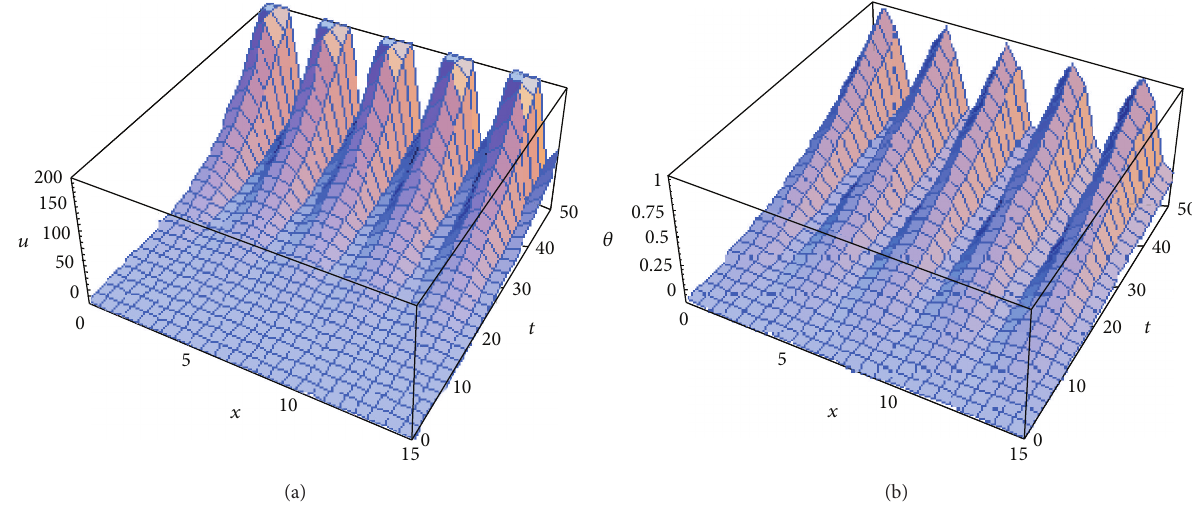
Figure 7: Variations of the displacement 𝑢 and the temperature 𝜃 for various values of the 𝑥 -axis and time 𝑡 when Ω = 𝜎 1 = 𝜎 2 = 0 , 𝜏 2 = 0.2 , = 0.1 , 𝛿 = 1 , and 𝜔 = 0.02 𝜏 1